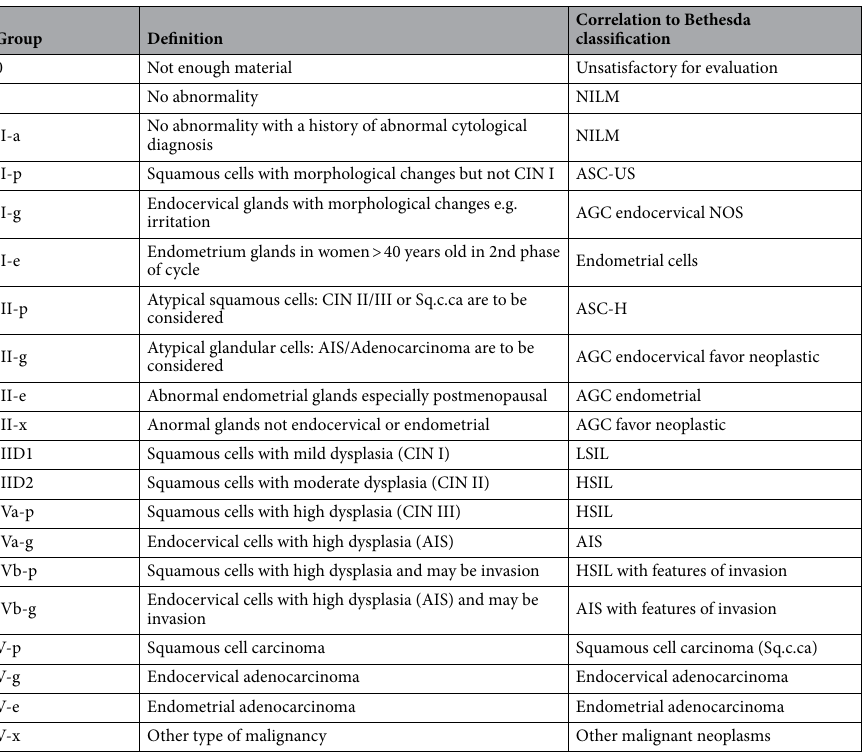
Table 3. Muenchener classification III with correlation to Bethesda classification. NILM Negative for intraepithelial lesion or